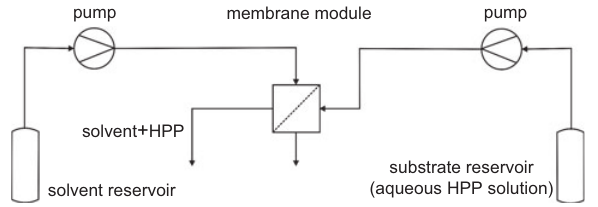
Figure 6 Set-up for the analysis of the product extraction.